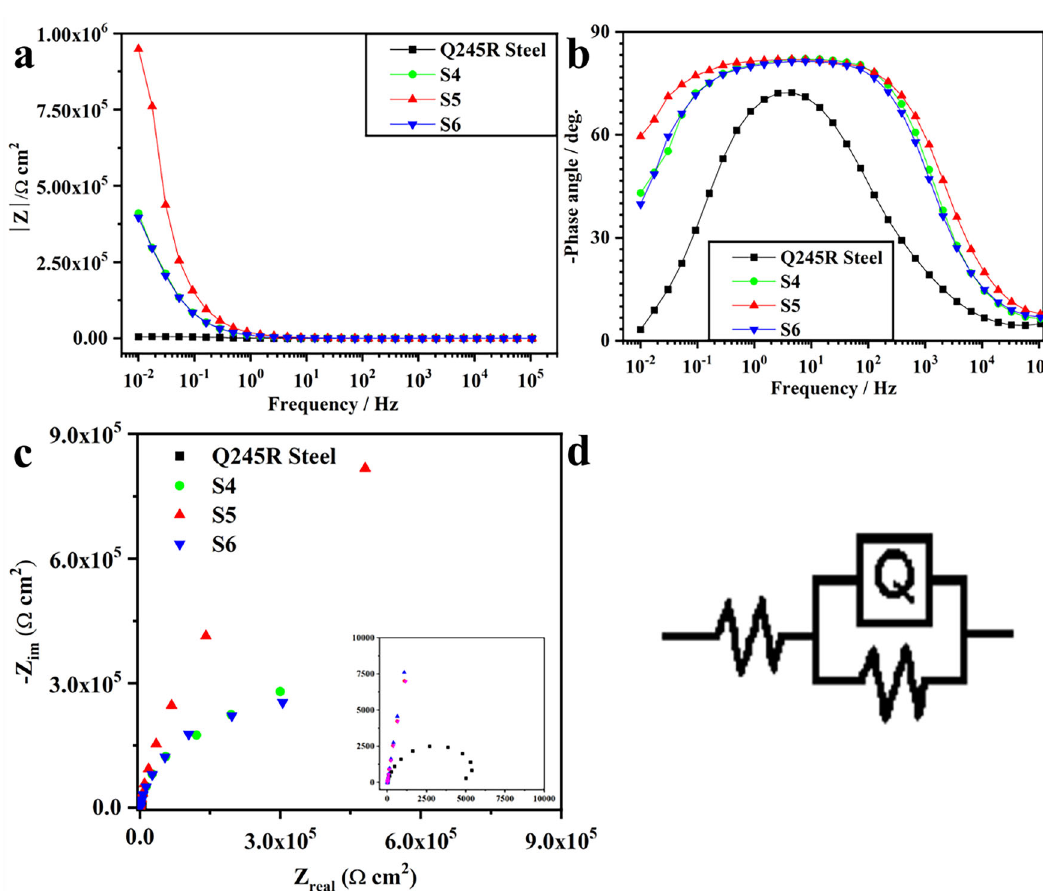
Fig. 9 The electrochemical impedance spectroscopy of Q245R steel substrate (black) and Inconel 625 coatings on Q245R steel: S4 (green), S5 (red), S6 (blue). a Bode plots (frequency); b bode plots (phase angle); c nyquist plots; d equivalent electrical circuit curve according to ( a